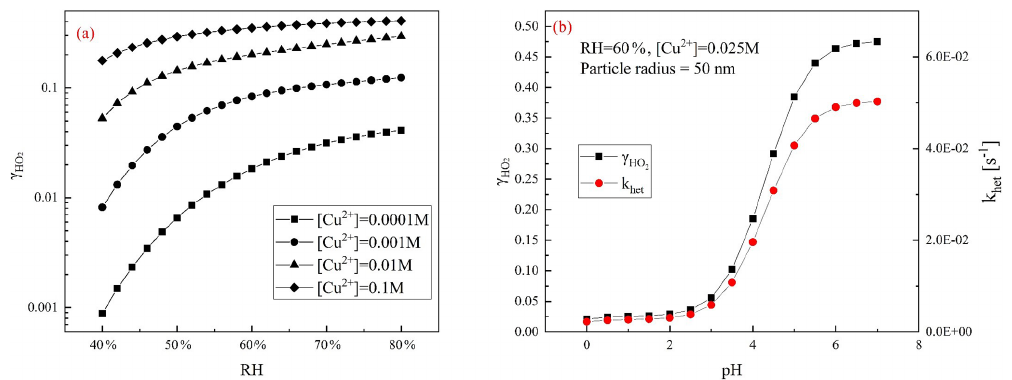
increases with the RH at different [Cu 2 + ]; 2